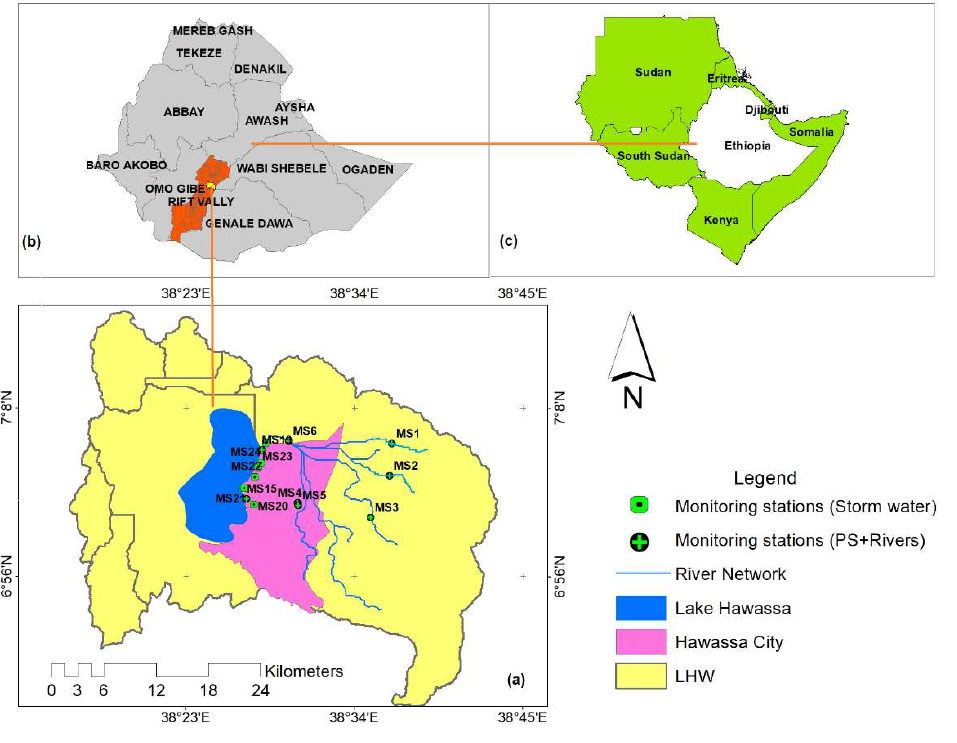
Figure 1. Study area map and monitoring station’s location. ( a ) Lake Hawassa watershed (LHW) and monitoring stations from point source (PS), rivers and stormwater, ( a ) Major river basins in Ethiopia, ( b ) countries sharing boundaries with Ethiopia ( c ).